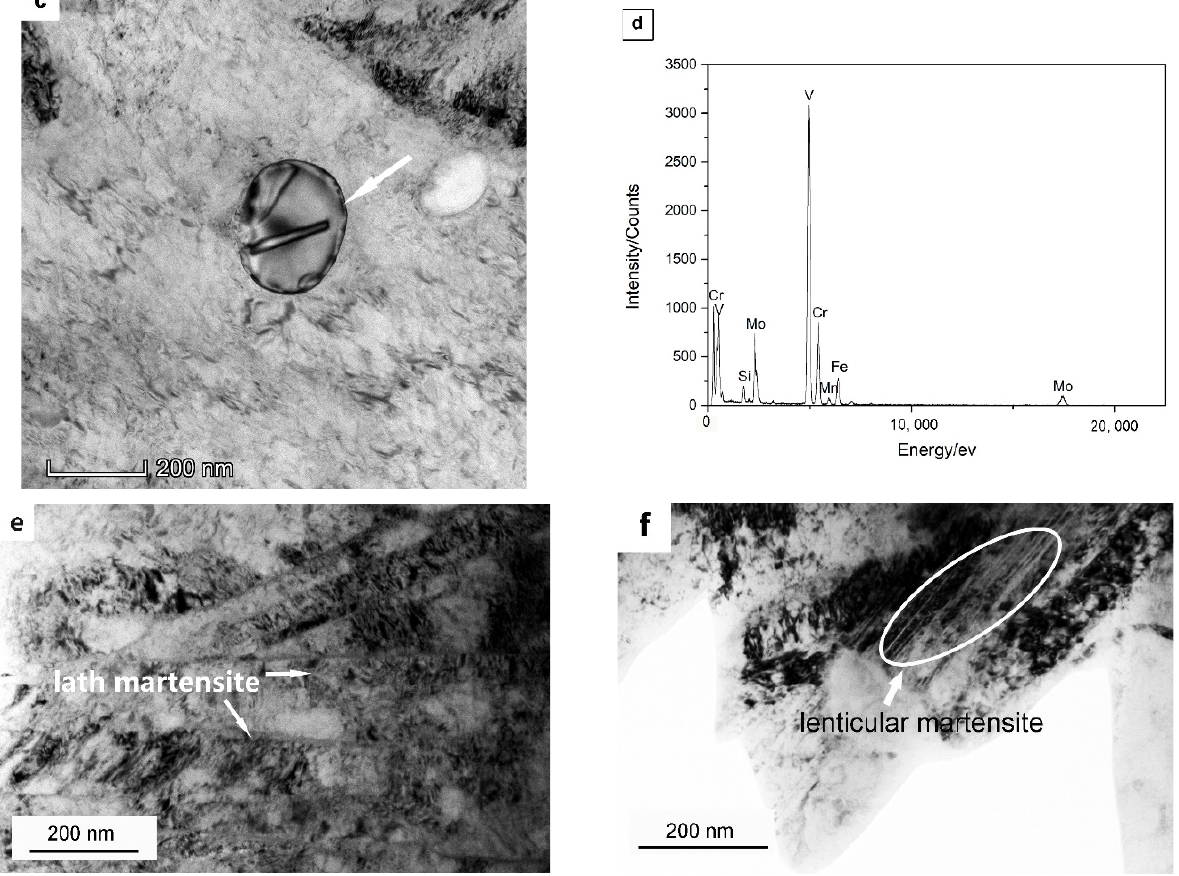
Figure 2. TEM images showing larger spherical carbides, lath martensite, and lenticular martensite after quenching at 1030 °C in Dievar steel: ( a , c ) bright field images of a typical larger spherical carbide; ( b ) SAD pattern for the particle in ( a ) consistent with the [3 − 9 1] zone axis of M 8 C 7 ; ( d ) EDS spectra for the particle in ( c ) , indicated by the white arrow; ( e ) lath martensite; ( f ) lenticular martensite.